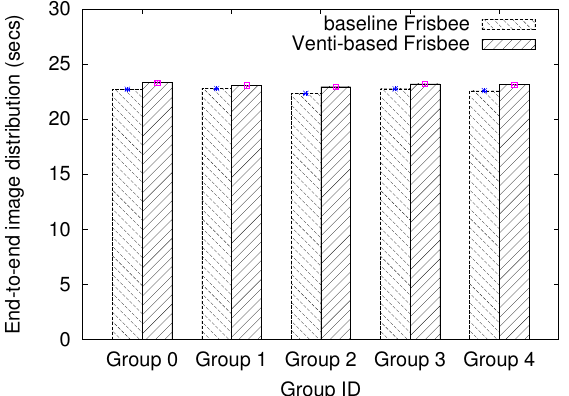
Figure 8: Average time to deploy an image to 20 clients with stag- gered start times. Clients start in five groups of four; for each group, we measure the time from client start to client finish. the same